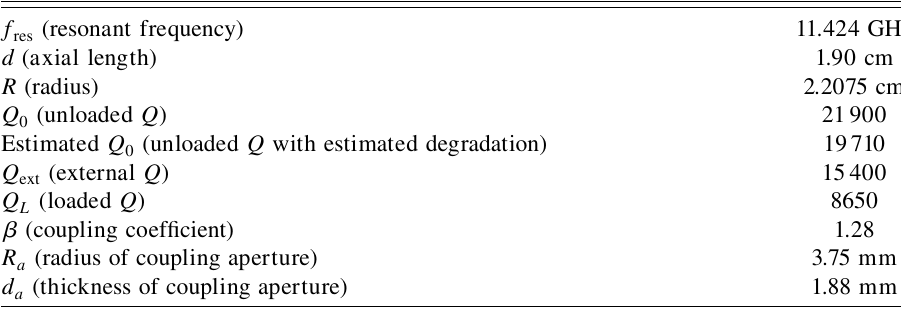
TABLE II. Cavity design parameters for the TE